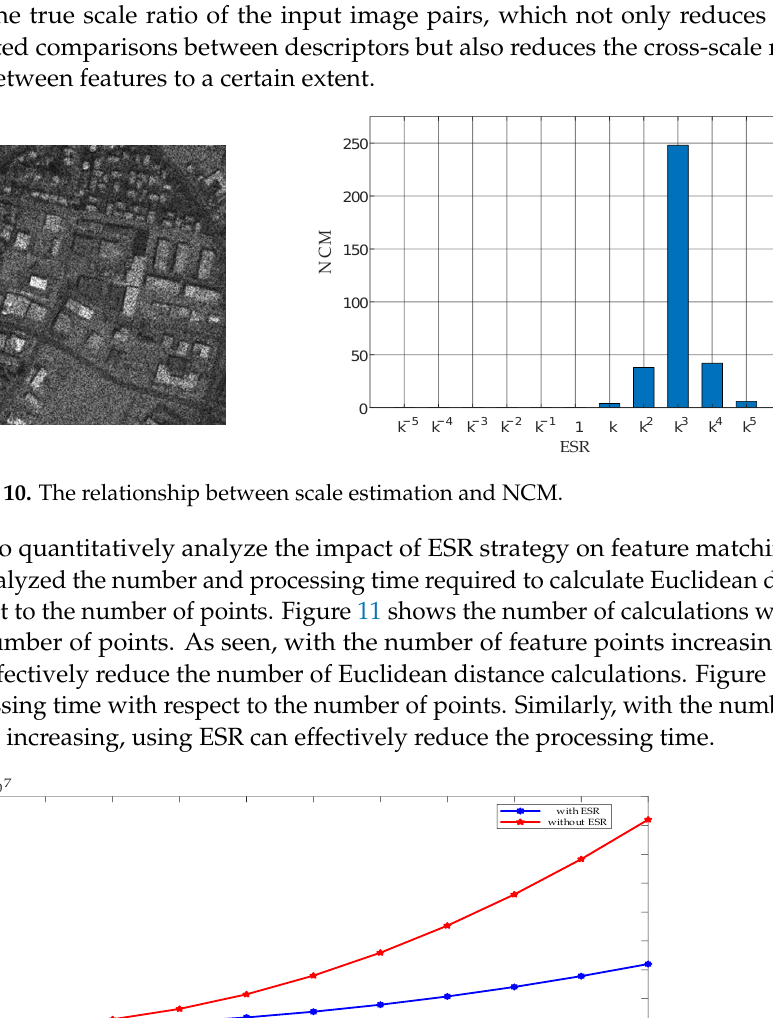
Figure 12. Processing time with respect to the number of points. 3.4. Contrast Experiments In this section, we utilize real image pairs to evaluate the performance of the pro- posed algorithm and comprehensively evaluate the experimental results qualitatively and quantitatively. To better analyze the advantages of the MSPCO algorithm, it is compared with SIFT, SAR-SIFT, OS-SIFT, HOPC, and RIFT. Figures 13–18 show the comparison results of the MSPCO algorithm with SIFT, SAR- SIFT, OS-SIFT, HOPC, and RIFT on six pairs of real optical and SAR images. Since the descriptor of the SIFT algorithm uses gradient information, its registration results are heavily dependent on the similarity of the gradient map of the image. However, the gra- dient is very sensitive to NRD, thus SIFT performs poorly on multimodal image registra- tion. All image pairs failed to be matched, indicating that SIFT can only register images with the same mode. Similar to SIFT, the descriptor of the SAR-SIFT algorithm is also built based on gradient information. Different from SIFT, given the serious speckle noise prob- lem of SAR images, SAR-SIFT provides a new definition of the gradient by changing the traditional difference gradient operator into a ratio gradient operator, which reduces the influence of speckle noise to a certain extent and improves the registration effect between SAR images. However, the redefined gradient does not weaken the influence of NRD, thus the registration effect of the multimodal image is poor. In all six registration experiments, no successful matching was achieved. The OS-SIFT algorithm is a registration algorithm specially used for optical and SAR images. According to the different characteristics of optical and SAR images, different gradient calculation forms are selected to obtain better registration results. In this paper, OS-SIFT completed the registration, except for the sec- ond and the sixth pairs of images. The descriptor of OS-SIFT was also constructed based on gradient information, which was robust to NRD to some extent. The second pair of images had a significant NRD, which directly led to the failure of the registration. For the sixth pair of images, there were more dark areas in the SAR image. The overall intensity of the image was weak, and the edge and texture information was less. Additionally, there